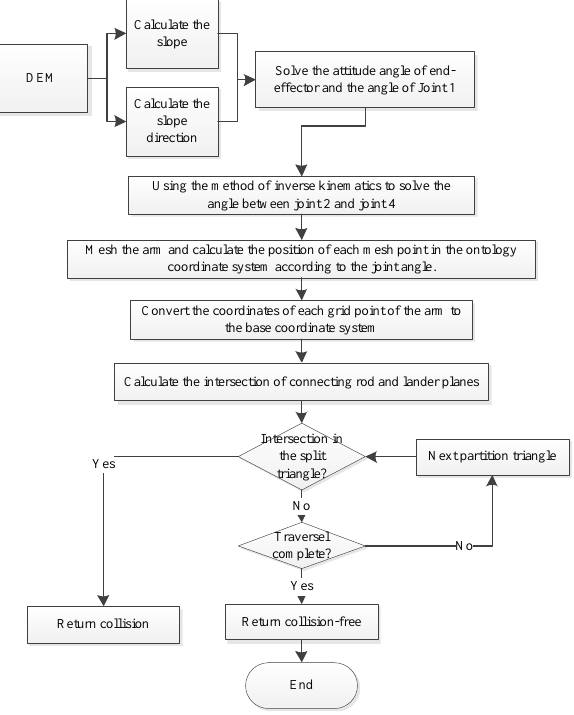
Figure 7. Diagram of the ontology interference